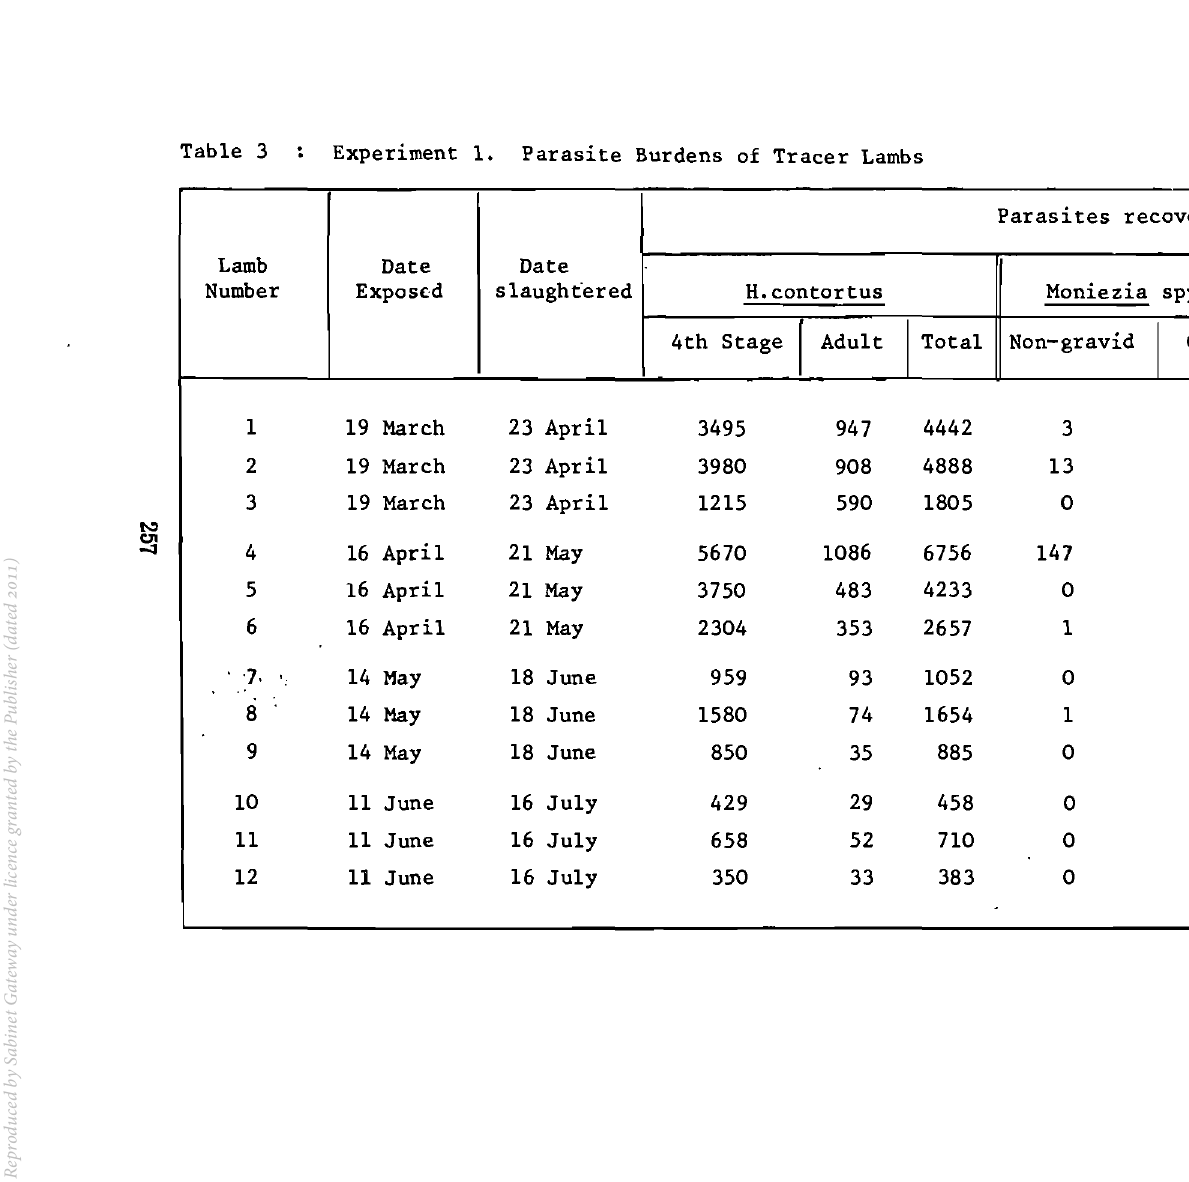
Table 3 Experiment 1. Parasite Burdens of Tracer